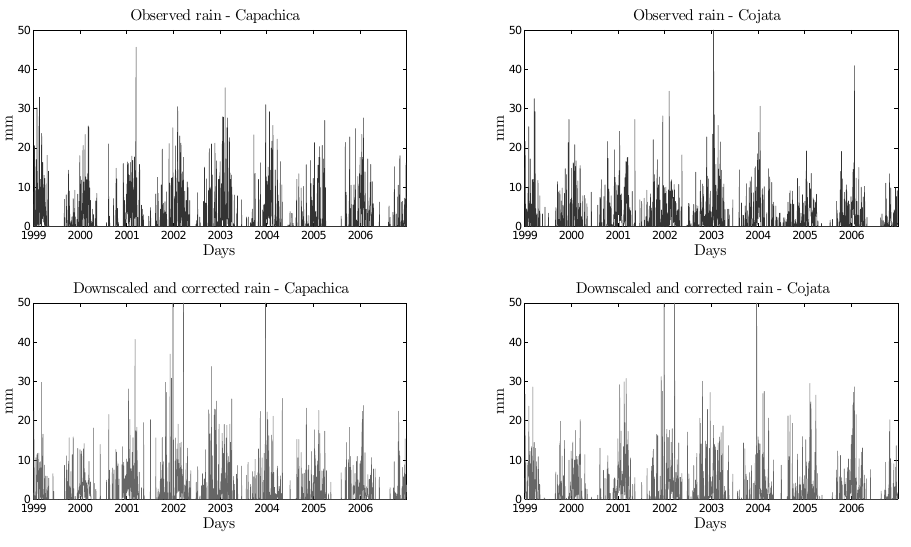
Figure 13. Observed and generated time series for the Capachica and Cojata stations.